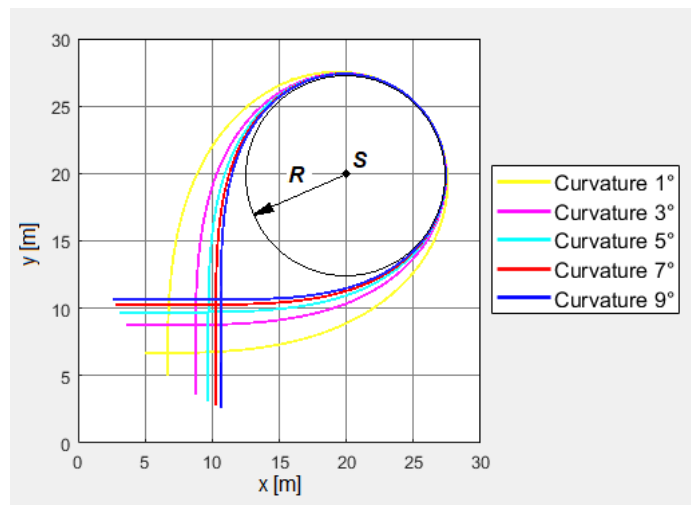
Figure 10. The “rho” (RHO) motion trajectories for the bi-curves whose curvature is described by the linear function as well as the third, fifth, seventh, and ninth degree polynomials.